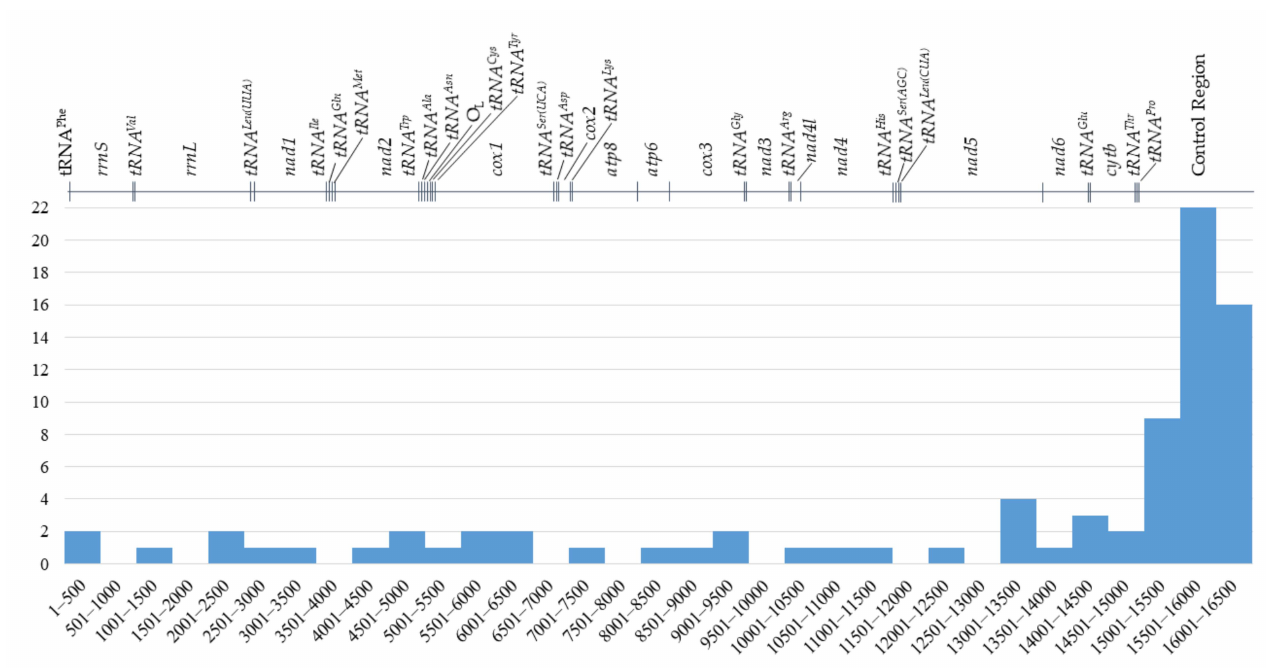
Figure 9. Distribution of single nucleotide variants (substitutions and indels) in the European mink mitogenome (X axis—position in bp, Y axis—number of variants).